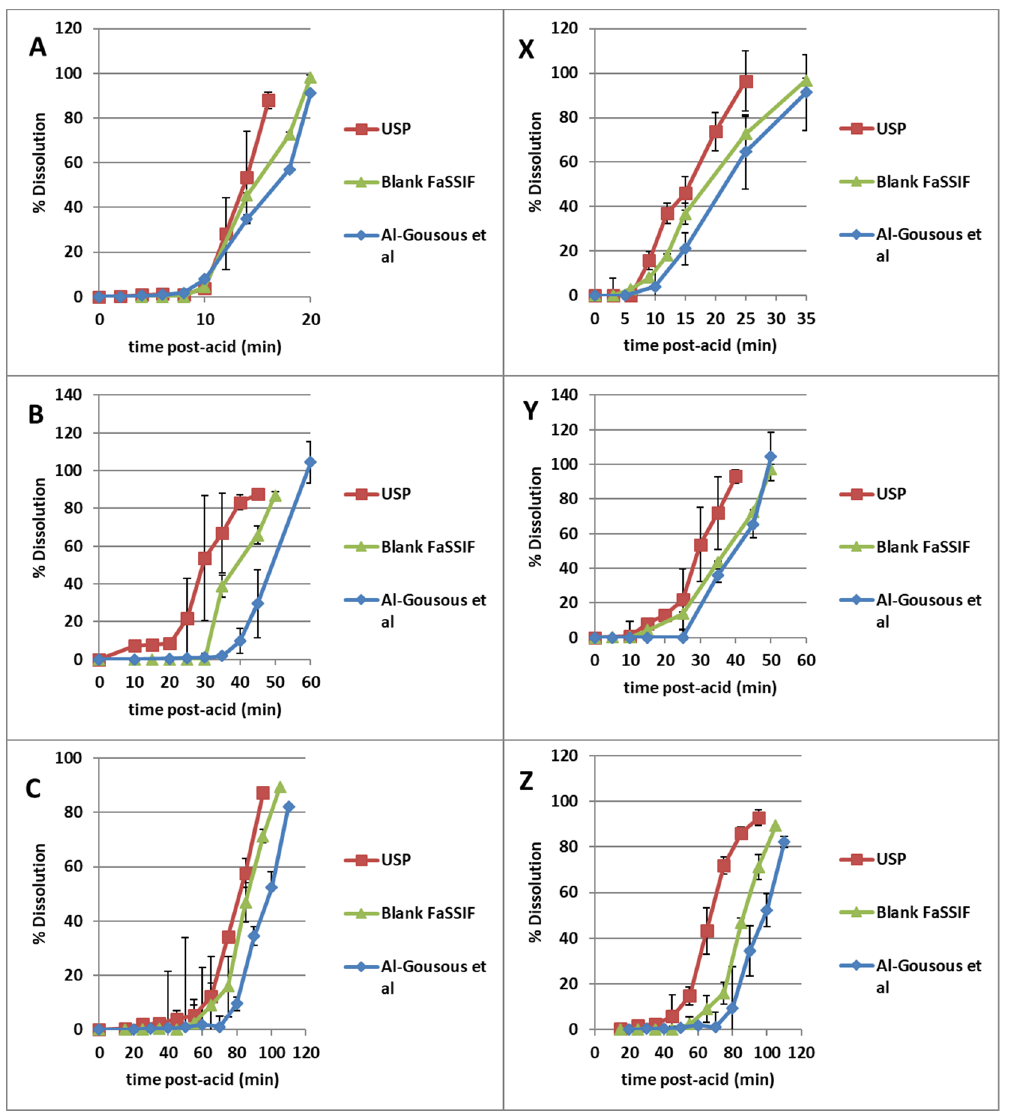
Figure 3. Dissolution test results (mean ± SD) of the tested formulations (n = 6). Panels ( A – C ) represent DRcaps®, HP-50 and HPMCAS-H respectively in basket apparatus, while panels X , Y and Z represent DRcaps®, HP-50 and HPMCAS-H respectively in paddle apparatus.